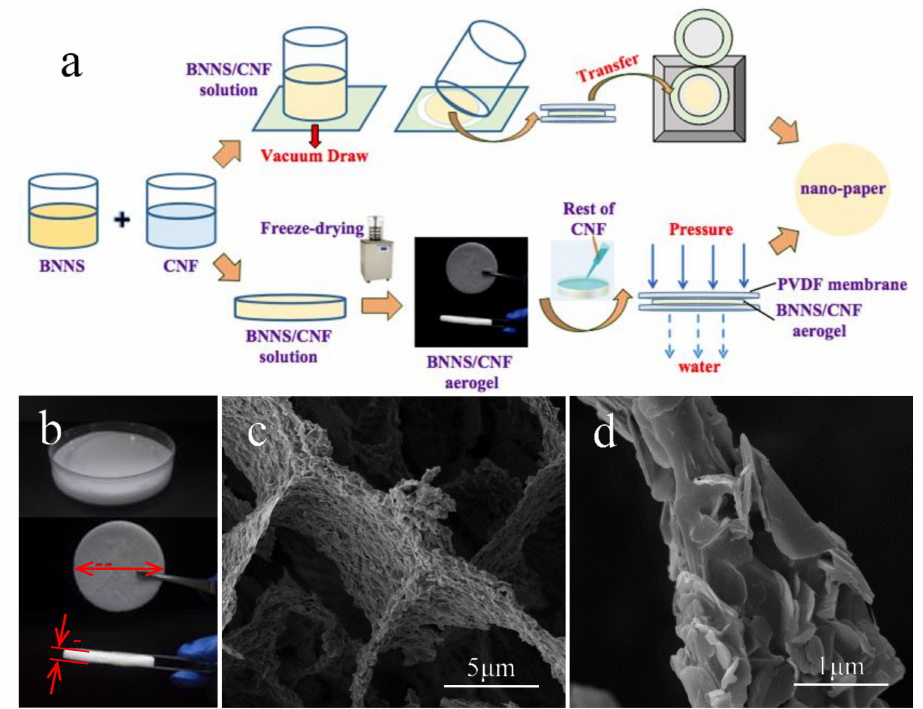
Figure 3. ( a ) Scheme of preparation of BNNS / CNF nano-papers, ( b ) Images of BNNS / CNF mixing solution and aerogel, ( c ) and ( d ) SEM images under di ff erent magnifications of BNNS / CNF